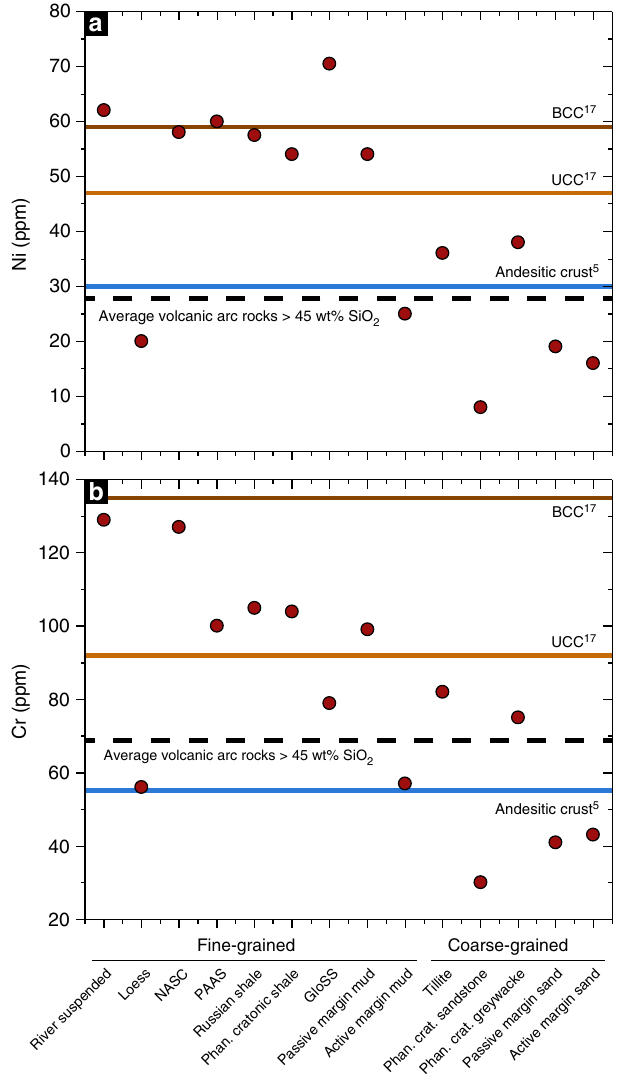
Fig. 1 Ni and Cr concentrations in continental sediments. Ni ( a ) and Cr ( b ) compositional data for various fi ne-grained and coarse-grained continental sediments based on the compilation in McLennan 21 relative to the Ni and Cr concentrations of the average andesitic crust 5 , upper (UCC) and bulk (BCC) continental crust 17 , and average volcanic arc (dashed black lines). NASC = North American shale composite, PAAS = Post-Archean average Australian shale, GloSS = average global subducting